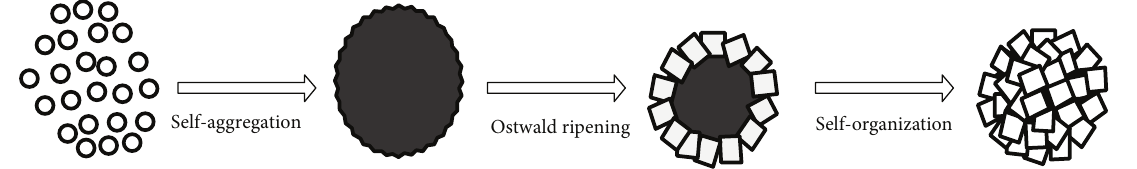
Scheme 1: Potential mechanism of forming the hierarchical flower-like superstructure of Bi 2 WO 6 .